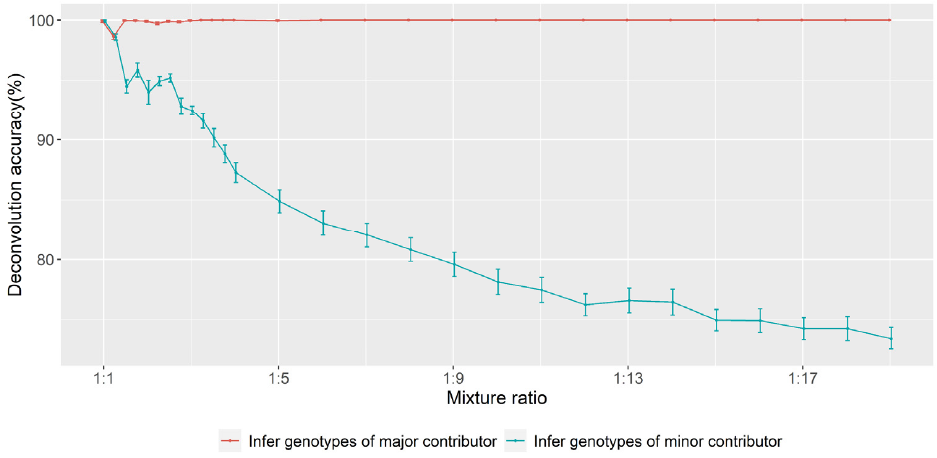
Figure 5. Deconvolution accuracy of non-parent–child in silico mixtures. The points represent the mean accuracy per ratio, and the error bars represent the standard error of the mean.